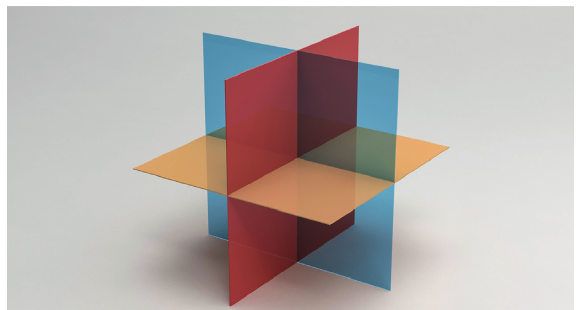
Figure 9: The space Eight Diagrams corresponds to the diagram of hexagrams.